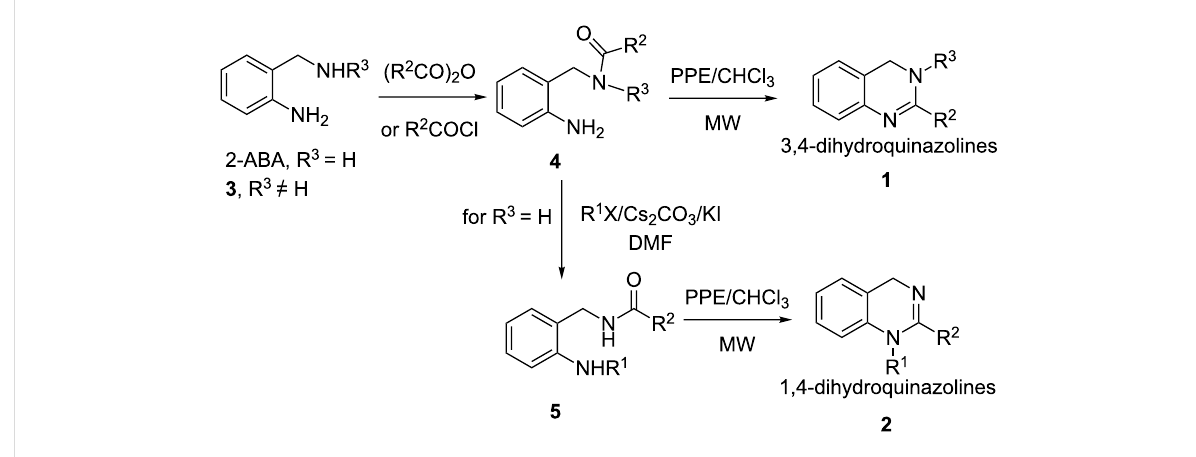
Scheme 1: Synthetic pathways for the preparation of 3,4-dihydroquinazolines 1 and 1,4-dihydroquinazolines 2 .